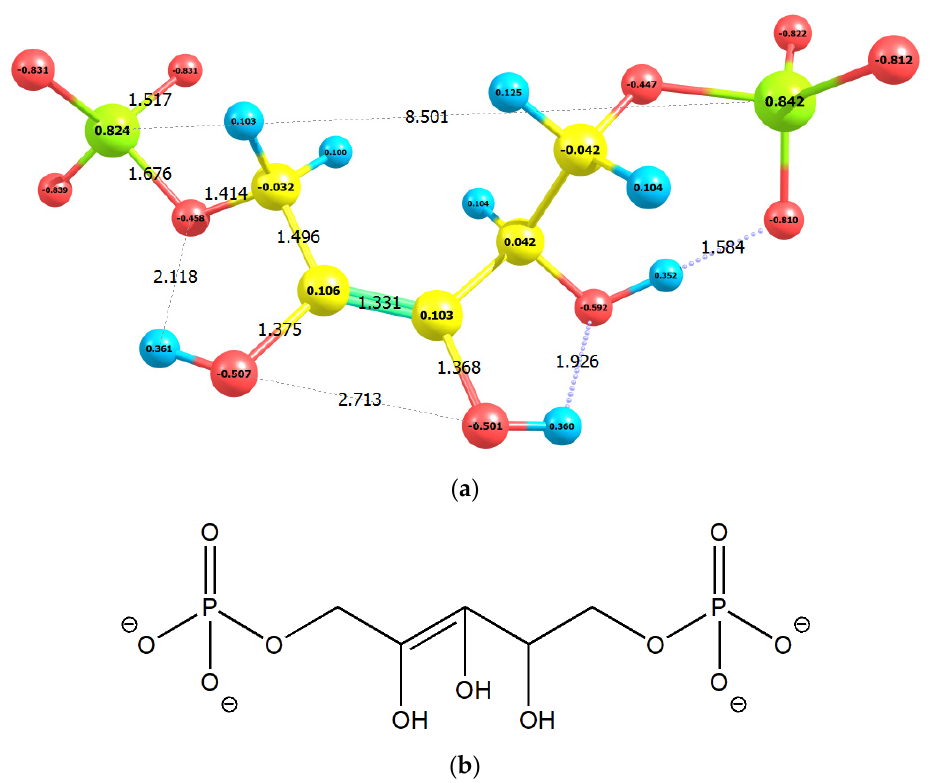
Figure A6. ( a ) The calculated geometric and electronic structure of 1/2-ene(mono/di)ol (2,3-enediol); Q = − 4, M = 1, E 0 = − 46,437.74 eV, G 0 = − 46,434.39 eV. Hessian has negative frequencies: − 24.51 (cm − 1 ). ( b ) The scheme of (Z)-2,3,4-trihydroxypent-2-ene-1,5-diyl diphosphate.